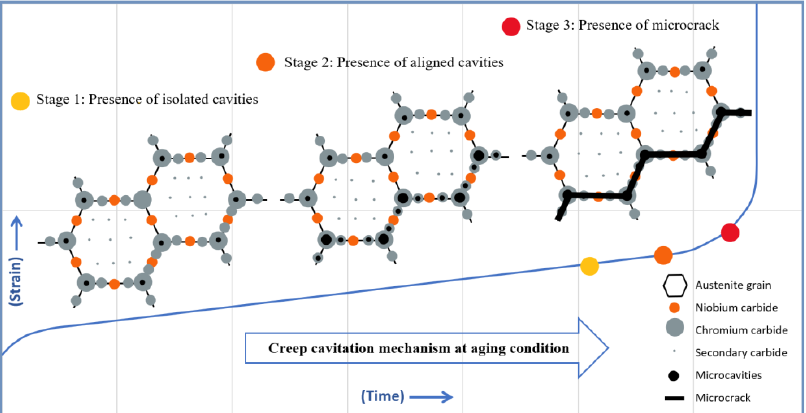
Figure 11. The initiation and growth mechanism for creep pores adjacent to interdendritic carbide particles during service transposed on a general creep graph.